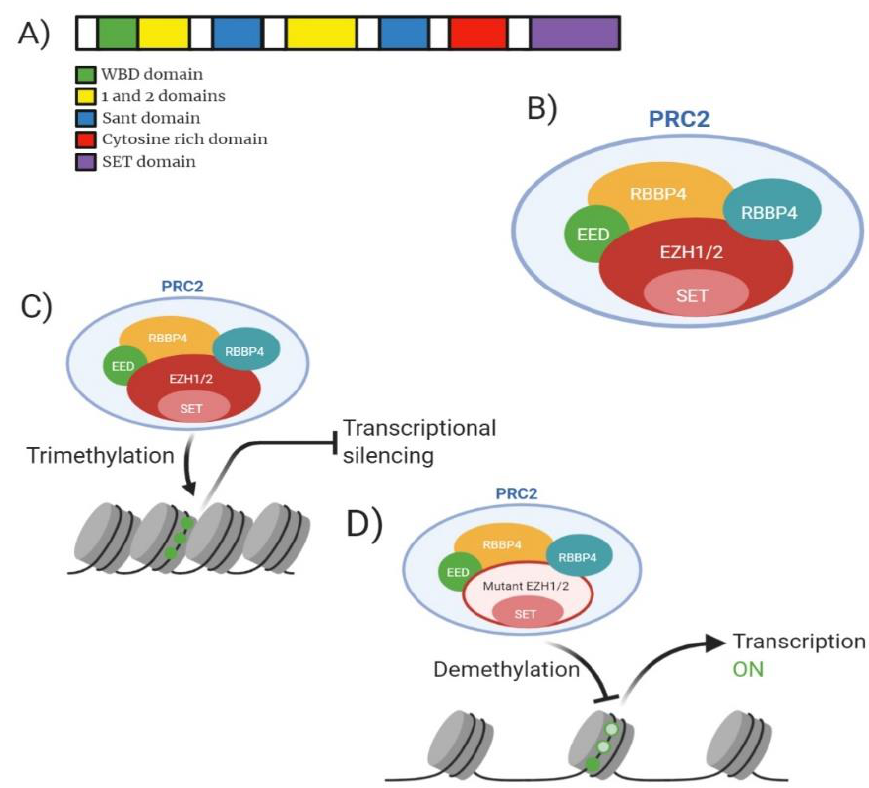
Figure 5. Analysis of EZH2 molecular structure, PRC2 structure, mechanism of action for wild-type and mutant and drug target action. ( A ) Domain structure of mammalian EZH2 enzyme consisting of 751 amino acid residues. Green highlighting WDB (WD-40 binding domain). Yellow highlighting domain ‘1’ which binds PHF1 and domain ‘2’ binding region for SUZ12 . Blue highlighting SANT domain allowing interaction of chromatin remodelling proteins with histones. Red highlights cytosine rich domain. Purple highlighting catalytic SET domain. ( B ) Model of mammalian PRC2 complex with core subunits. ( C ) Mechanism of action for wild-type EZH2 showing trimethylation of H3K27 resulting in gene transcription silencing. ( D ) Mechanism of action for PRC2 containing mutant EZH2 showing reduced methylation of H3K27 resulting in increased gene transcription. EZH2 is implicated in 2.59% of MDS cases, 0.94% of AML cases and 0.80% of MPN cases and generally confer a poor prognosis [62,63]. EZH2 is the most frequently associated PRC2 member implicated in myeloid malignancies [9]. Majority of EZH2 heterozygous mutations occur at tyrosine 641 (Y641) located in the SET domain resulting in gain of function mutations [64]. It is also worth noting that studies suggested the dual role of EZH2 as an oncogene and a tumour suppressor. Tumour suppressor function of EZH2 was identified as an interaction partner with MLL-AF9/AML1-ETO9a AML [65]. Basheer et al. discovered that the deletion of EZH2 resulted in accelerated disease progression and reduced survival when occurring together with MLL-AF9/AML1-ETO9a suggesting that the presence of EZH2 can function to provide full oncogenic effects; adding another layer of complexity to the multitude of effects EZH2 contributes to cancer [65]. Mutations at Y641 can be a multitude of amino acid conversions; Y641F (Tyrosine-Phenylalanine), Y641N (Tyrosine-Asparagine), Y641S (Tyrosine-Serine), Y641H (Tyrosine-Histidine) or Y641C (Tyrosine-Cysteine). The mutants formed show increased affinity for H3K27me2 or H3K27me3 compared to WT- EZH2 which expresses preference for unmethylated H3K27 or H3K27me1 [66]. Shen et al. have shown that the knockout of EZH2 in